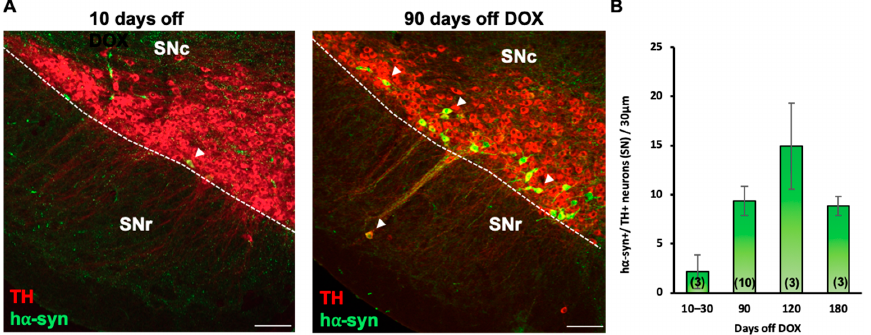
Figure 1. Inducible human A53T alpha synuclein accumulates over time. ( A ) Confocal images of coronal section (30 μ m) through the substantia nigra compacta (SNc) and reticulata (SNr) of the PITX3-IRES2-tTA/tetO-A53T double-transgenic mice showing a substantial increase of h α -syn ex- pression after 90 days off doxycycline (DOX) when compared to 10 days off DOX. Colocalization shows that h α -syn was selectively expressed in the TH+ cells (arrowheads) in the SN. Scale bars = 100 μ m. ( B ) Quantification of neurons displaying h α -syn /TH colocalization shows a 2-fold increase in h α -syn expression after 90 days off DOX and a 3-fold increase after 120 days. The expression after 180 days off DOX was comparable to 90 days off DOX. Graphs show mean ± SEM. The number of animals is annotated in parentheses for each condition.